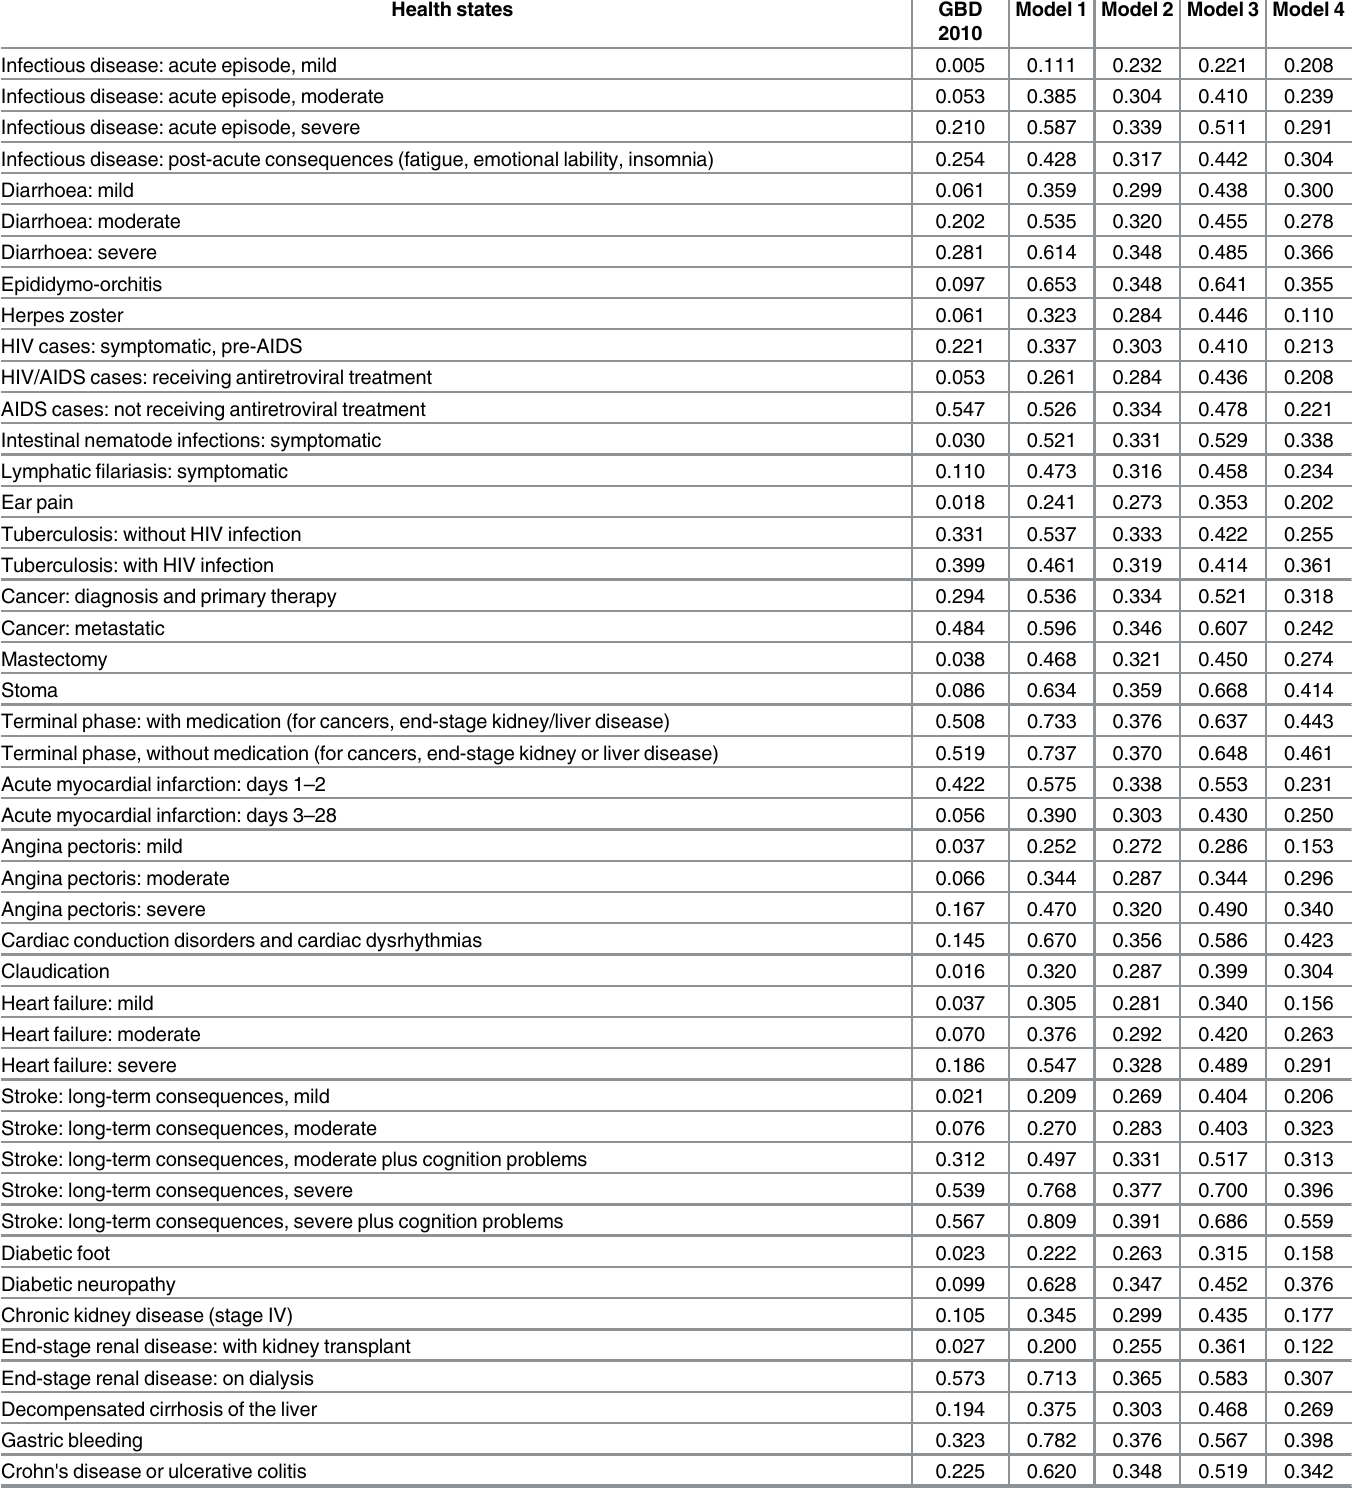
Table 2. Disability weights for the health states of each